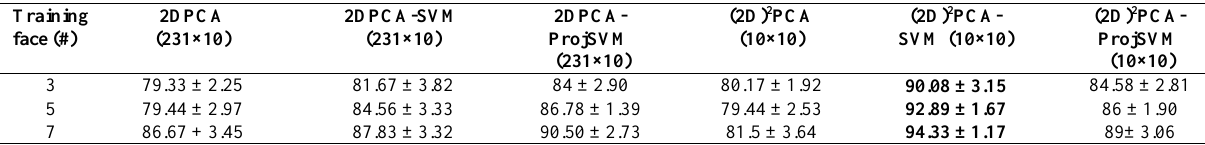
Table 2. Mean classification accuracy (in percent) over 10 random runs for Yale dataset with reduced dimension of 10 using 2DPCA and (2D) 2 PCA as dimensionality reduction methods.